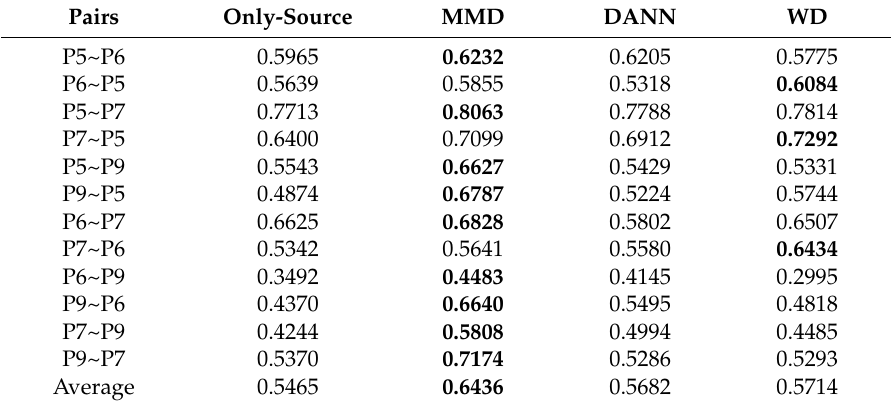
Table 6. The first round of experiment results of USC. We also randomly selected 4 users from the USC, namely P5, P6, P7 and P8, and transferred between each pair. In this round of experiments, Target used 60% of the unlabeled data to participate in the training, using the remaining 40% for testing. The bold number is the best result for the experiments in the same row.